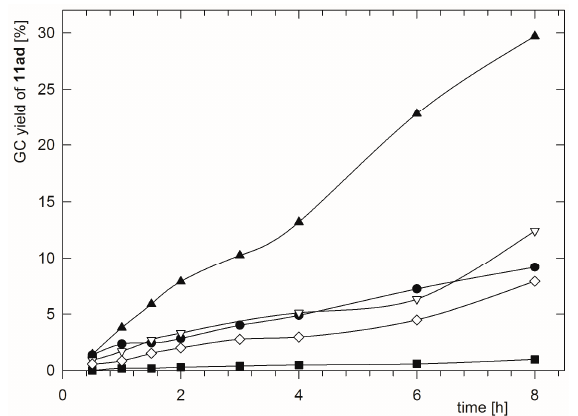
Figure 5. Kinetic profiles for the model coupling reaction performed in the presence of different catalysts: Pd(OAc) 2 ( ), catalyst 5 ( ), catalyst 6 ( ), catalyst 7 ( ), and catalyst 8 ( ). Conditions: 0.1 mol.% Pd, alkyne 9a (1 equiv.), acyl chloride 10d (1.5 equiv.), triethylamine (5 equiv.), dodecane (1 equiv.; internal standard) in acetonitrile solvent at 30 °C. The solid lines connecting the experimental points serve as a visual guide and do not represent any fit of the data.